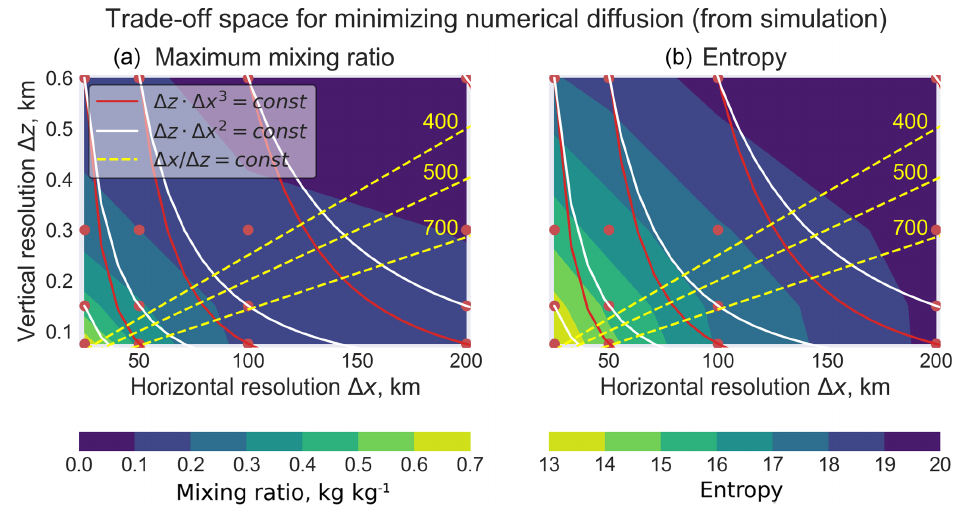
Figure 7. Optimal combination of horizontal and vertical grid resolutions ( (cid:49)x and (cid:49)z ) for minimizing numerical diffusion of chemical plumes within a given amount of computational resources. Results are from the FV3 simulation (data from Figs. 4 and 6) and can be compared to Fig. 1 that shows similar results from theoretical analysis. The filled contours show the maximum plume mixing ratio (a) or entropy (b) on day 8 of the simulations as metrics of numerical diffusion. High maximum mixing ratio and low entropy are indicative of low numerical diffusion. The red dots are the data points used to construct the contours, with each point corresponding to a simulation at a given resolution. The solid lines indicate a fixed amount of computational resources ( P ) in the trade-off between horizontal and vertical resolution, either using a fixed time step ( (cid:49)z(cid:49)x 2 = P ) or accounting for the CFL condition ( (cid:49)z(cid:49)x 3 = P ). The yellow dashed lines show different (cid:49)x /(cid:49)z ratios (400, 500,